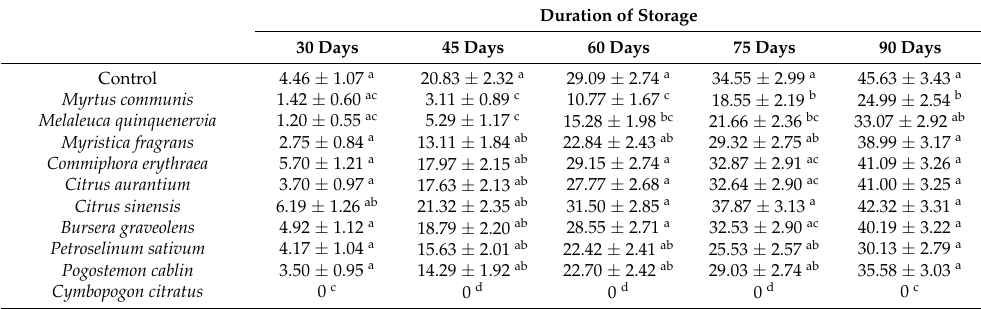
Table 3. Longest sprout length (mm) of potato tubers treated with different essential oils at different time points.